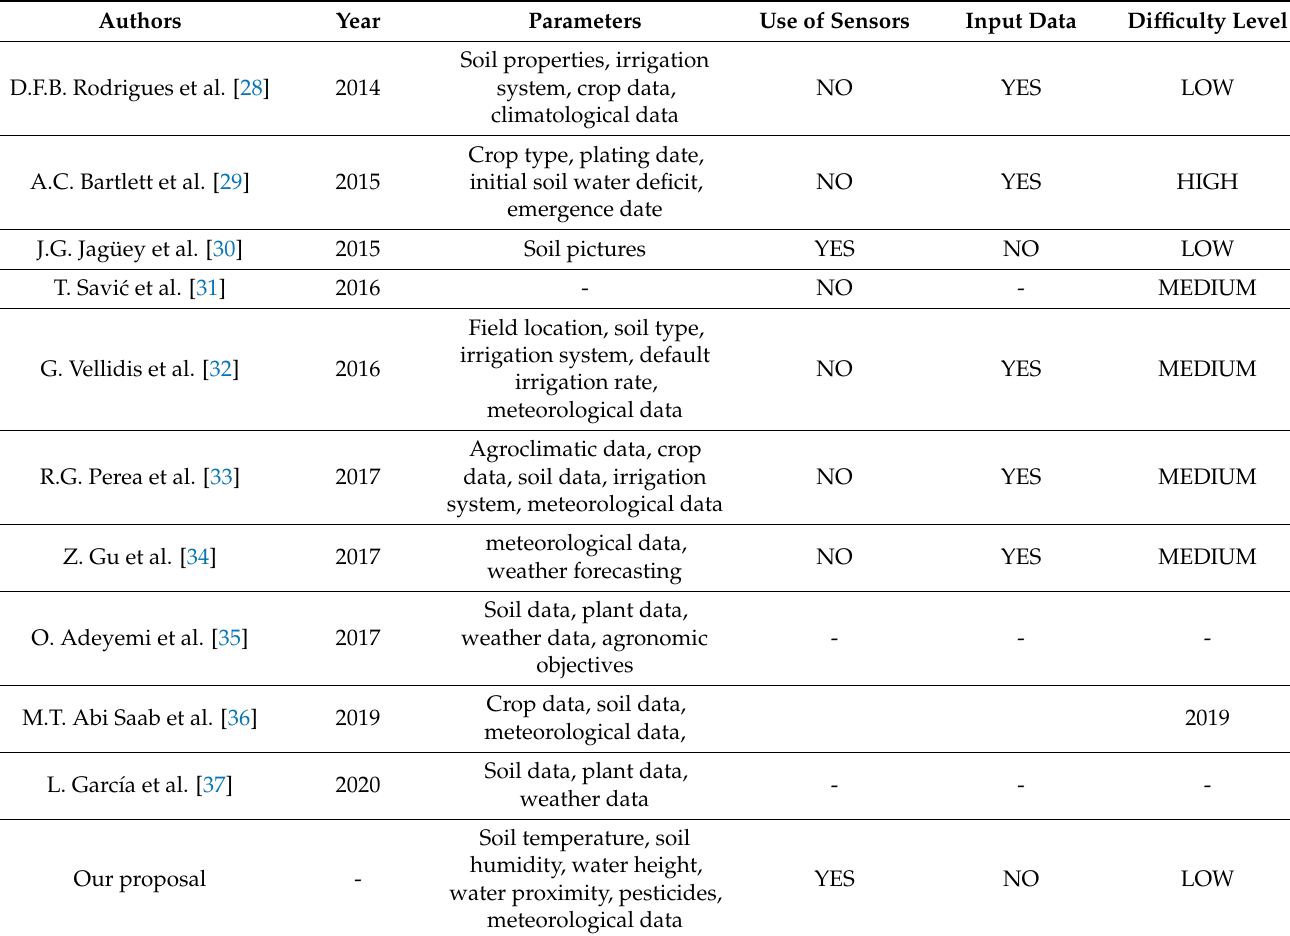
Table 6. Comparison of related